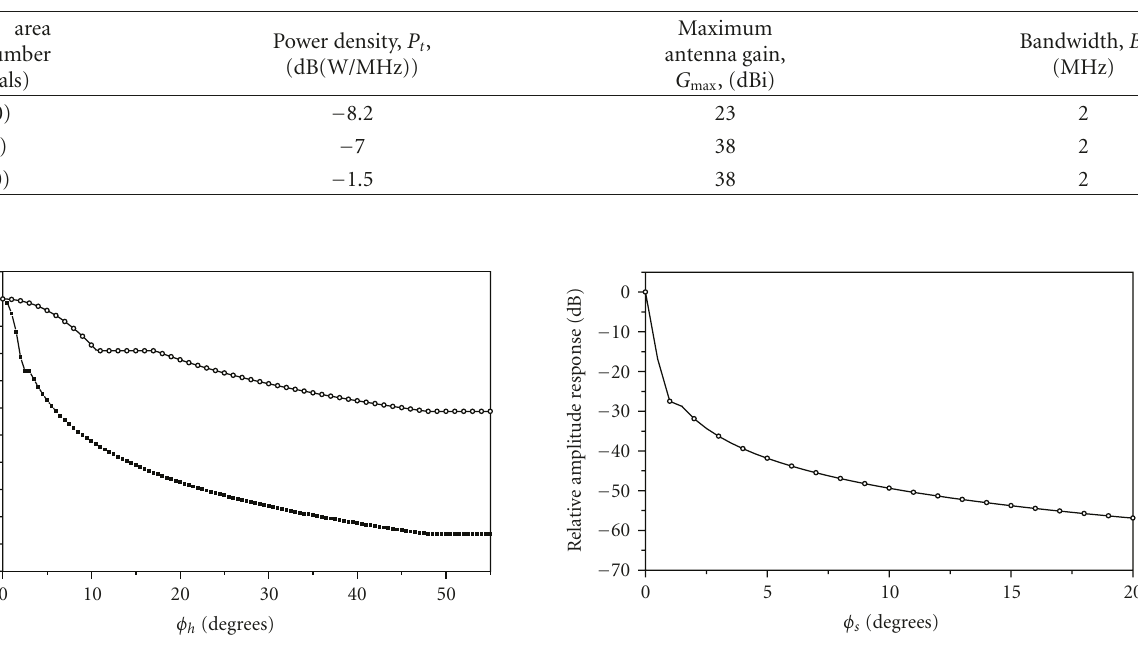
Table 2: HUT transmitter parameters.